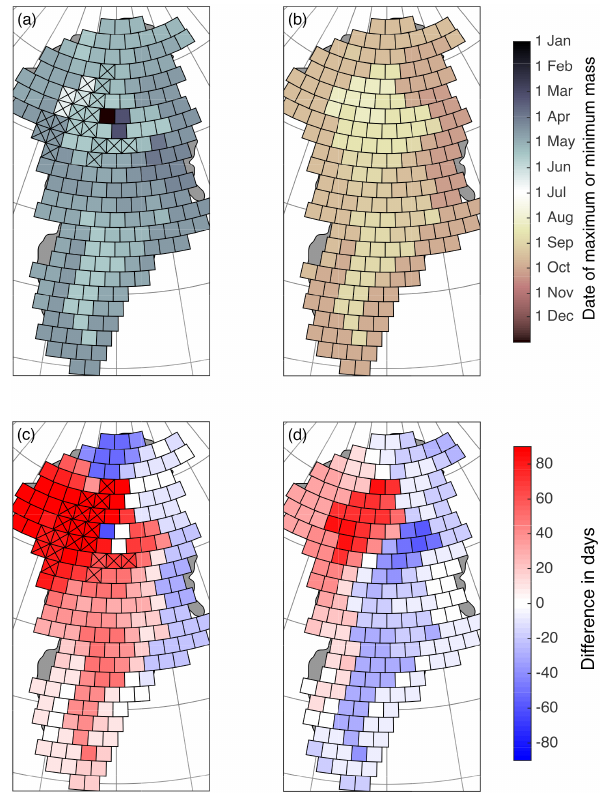
Figure 10. Timing in peaks of the seasonal cycle of detrended cu- mulative MB simulated by GRACE-LM-filtered MAR v3.5.2 + ISSM outputs. (a) The timing of the maximum peak for each mas- con, and (b) the timing of the minimum peak for each mascon. The number of days between MAR v3.5.2 + ISSM and the GRACE- LM median dates for the cycle maximum and minimum are shown in (c) and (d) respectively. For (c) and (d) , red colors indicate that the model date occurs later than that of GRACE-LM, and blue col- ors indicate an earlier date. “x” marks indicate where the modeled peak falls outside of the error range of dates for the GRACE-LM peak shown in Fig. 9.